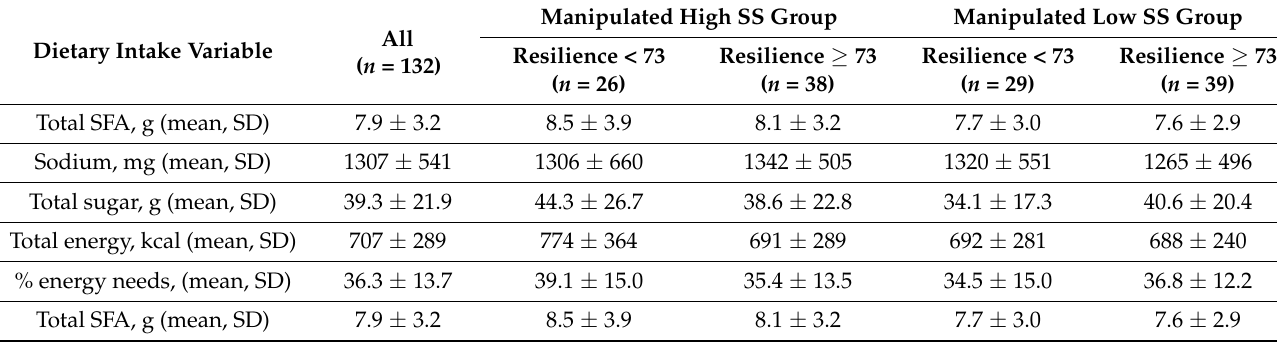
Table A2. Dietary Intake by SS Condition and Resilience Level.